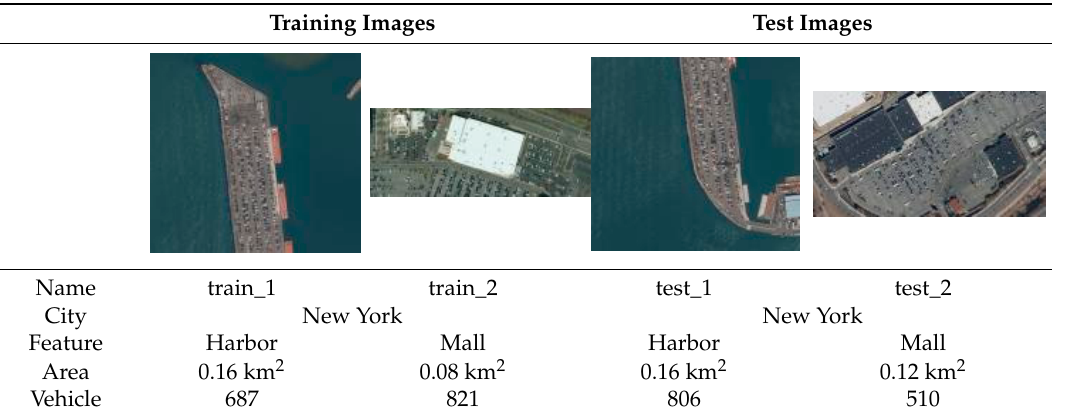
Table 1. Training and test images.